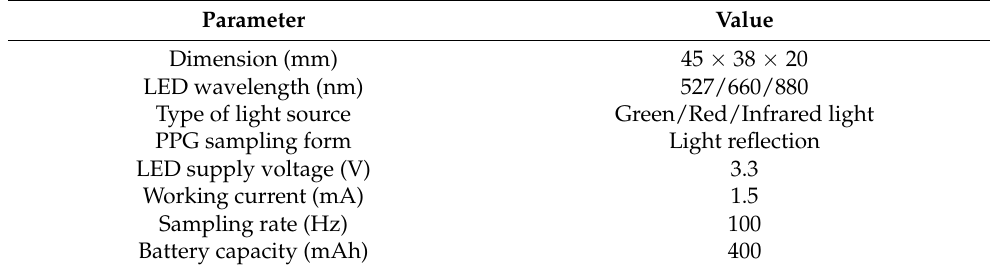
Table 1. Parameters of PPG acquisition equipment.